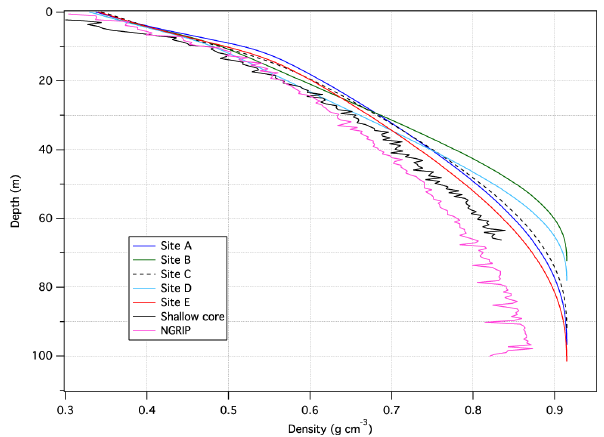
Figure 9. Firn density profiles determined from seismic shallow re- fraction data at sites A–E (Fig. 4). Note that density in all profiles approaches ice density (917kgm − 3 ) by ∼ 90m, but that the sites in the shear margins (B and D) exhibit higher densification rates. For comparison, the directly measured densities of the NEGIS shallow core (black line) and NGRIP ice core (pink line) are also